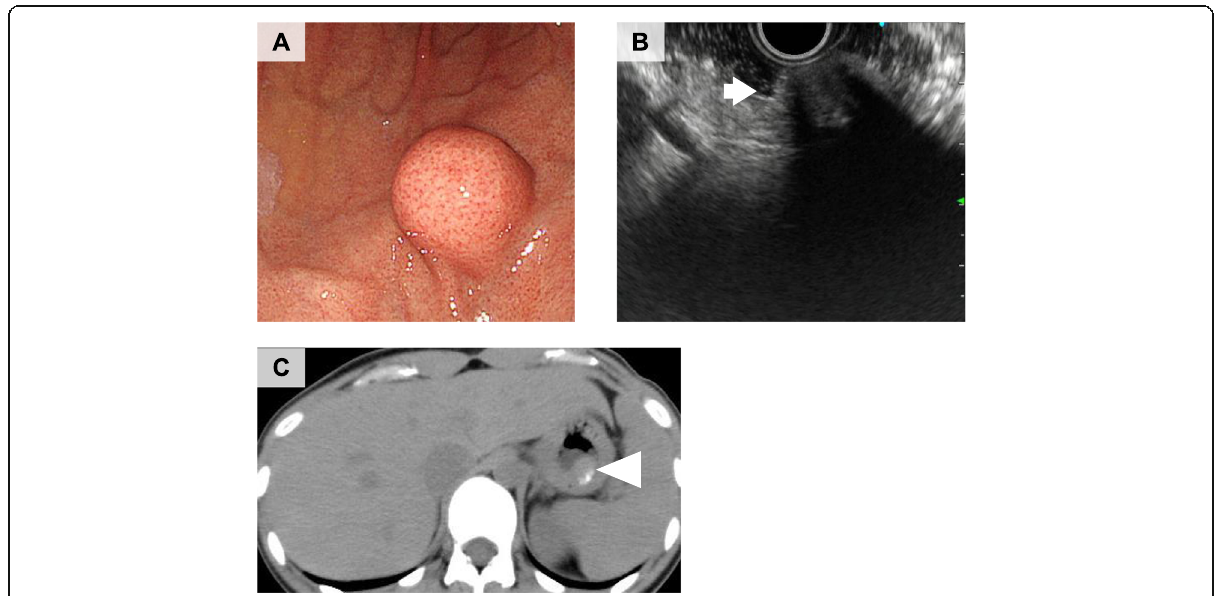
mucosal tumor ( c , arrowhead)